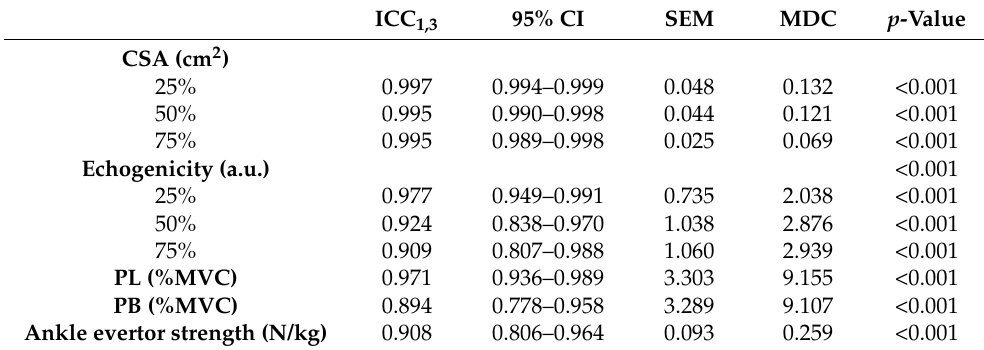
Table 2. ICC 1,3 of the peroneus muscles CSA, echogenicity, PL and PB muscle activities, and ankle evertor strength